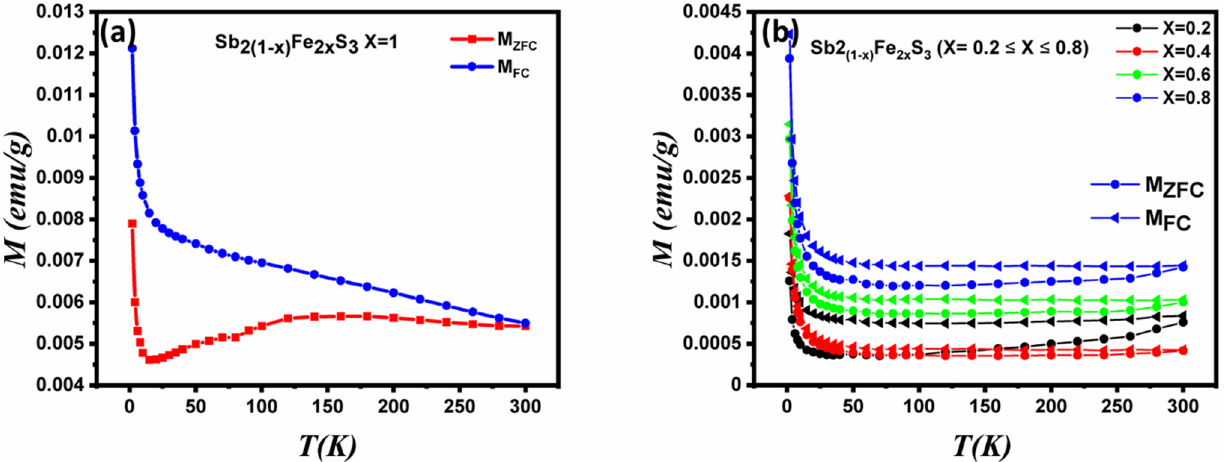
Figure 8. Plots of magnetization vs. temperature for Sb 2(1 − x ) Fe 2 x S 3 ( a ) x = 1 ( b ) 0.2 ≤ x ≤ 0.8, measured in zero-field-cooled (ZFC) and field-cooled (FC) regimes, with 100 Oe applied field.